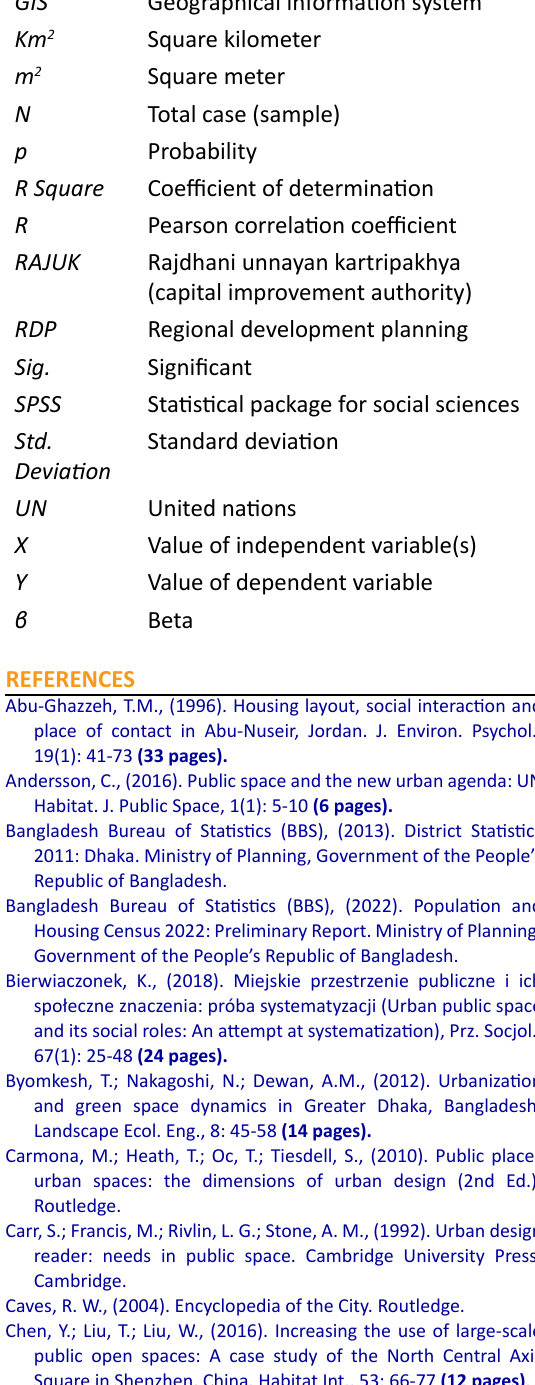
Fig. Figure GIS Geographical information